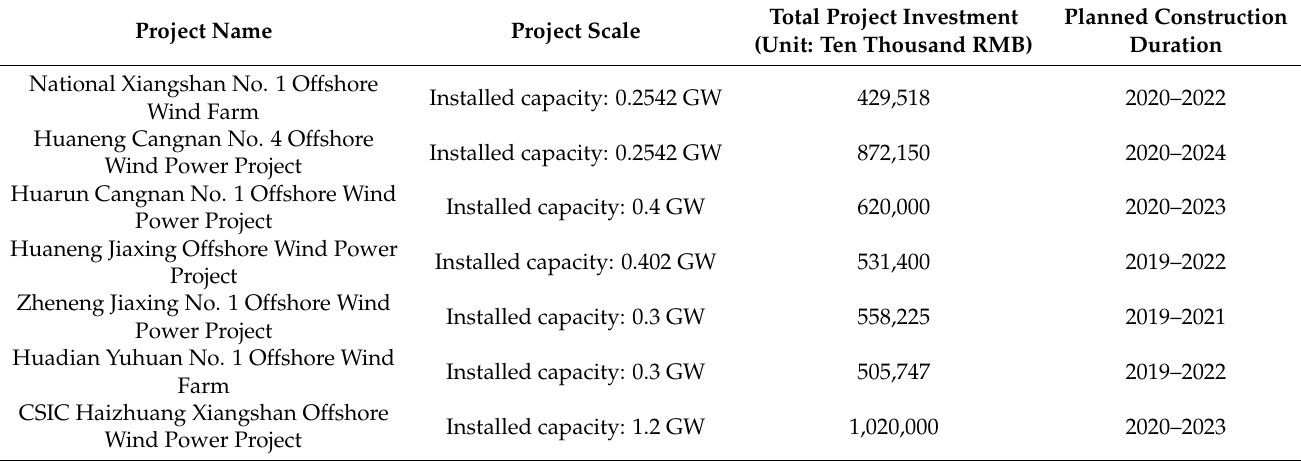
Table 1. Progress plan of key wind power projects in